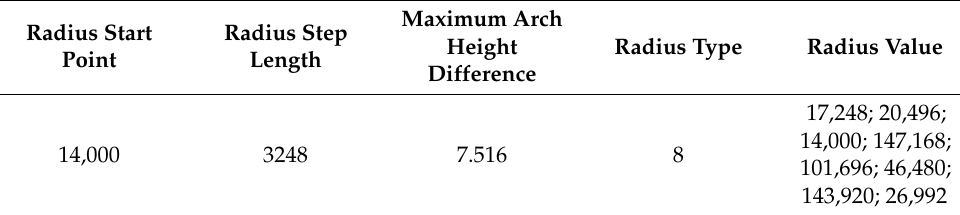
Table 4. Optimization results of the three-span and one-break main curved